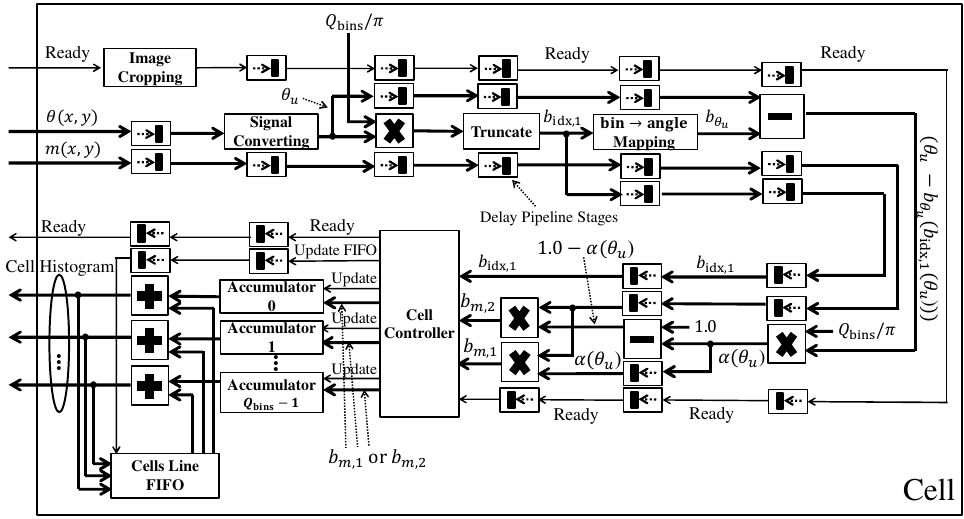
Figure 7. The cell histogram